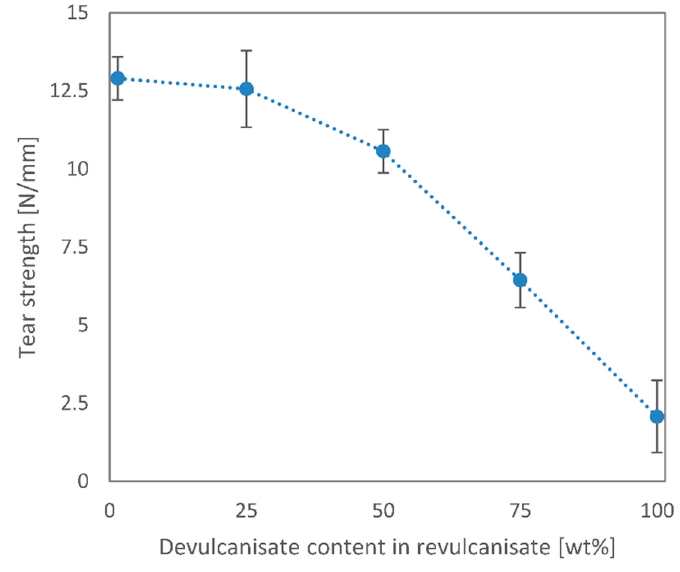
Figure 6. Tear strength of revulcanisates vs. devulcanisate content.